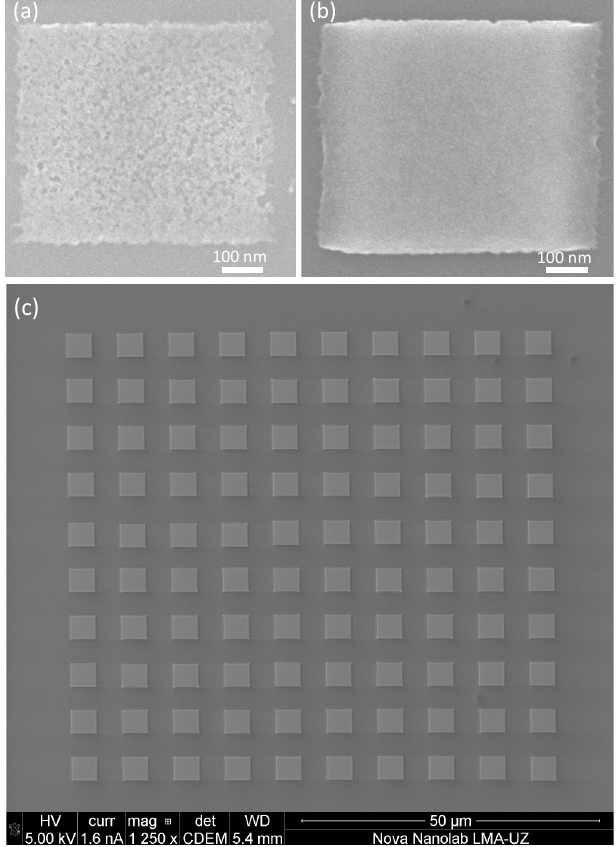
Figure 4. ( a ) SEM micrograph of a W-C 30-nm thick Cryo-deposit irradiated with a 4.21 μ C/cm 2 dose (unoptimized dose); ( b ) SEM micrograph of a W-C 30-nm thick Cryo-deposit irradiated with a 35.7 μ C/cm 2 dose (optimized dose); ( c ) SEM micrograph of a W-C Cryo-deposit array, composed of 100 rectangles of 4 μ m 2 x 3.85 μ m 2 in size, grown in a single Ga + irradiation exposure using an irradiation dose of 50 μ C/cm 2 , amounting to a total irradiation time of 85 seconds (compared with 14 hours using RT FIBID). Adapted and reprinted from Córdoba et al., Scientific Reports 2019 [55].